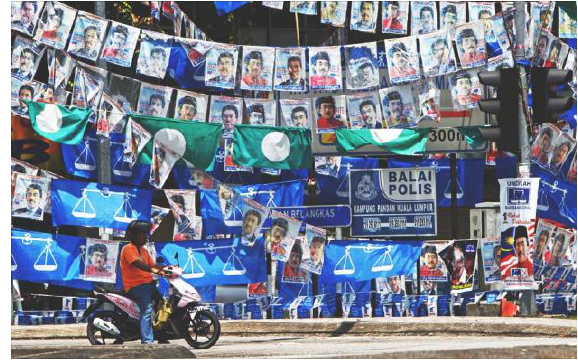
Figure 1. Election campaign in